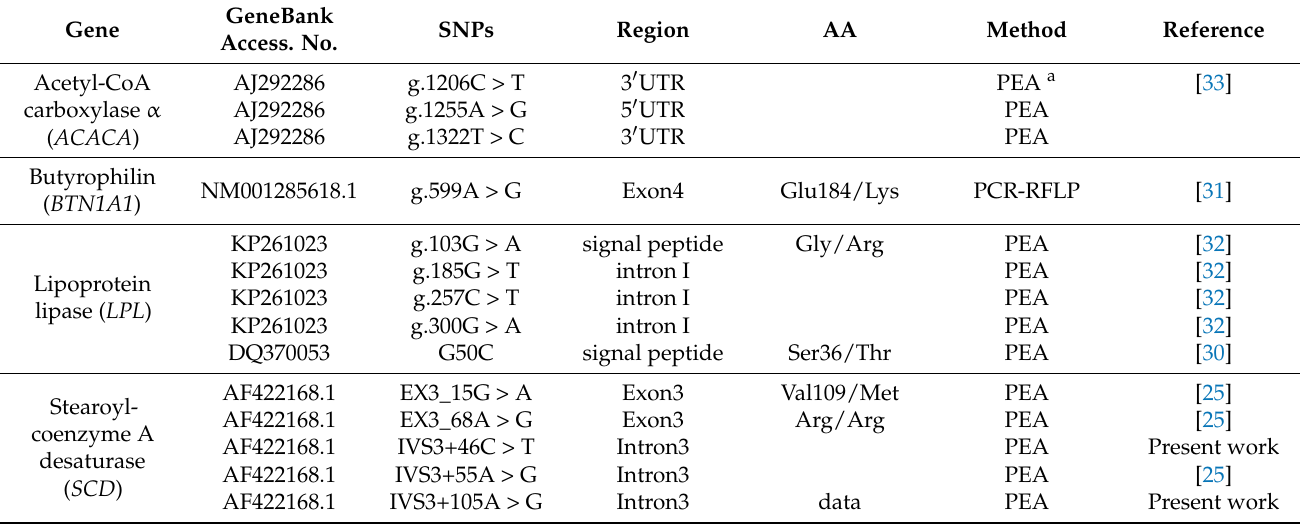
Table 1. Analysed SNPs and methods used.